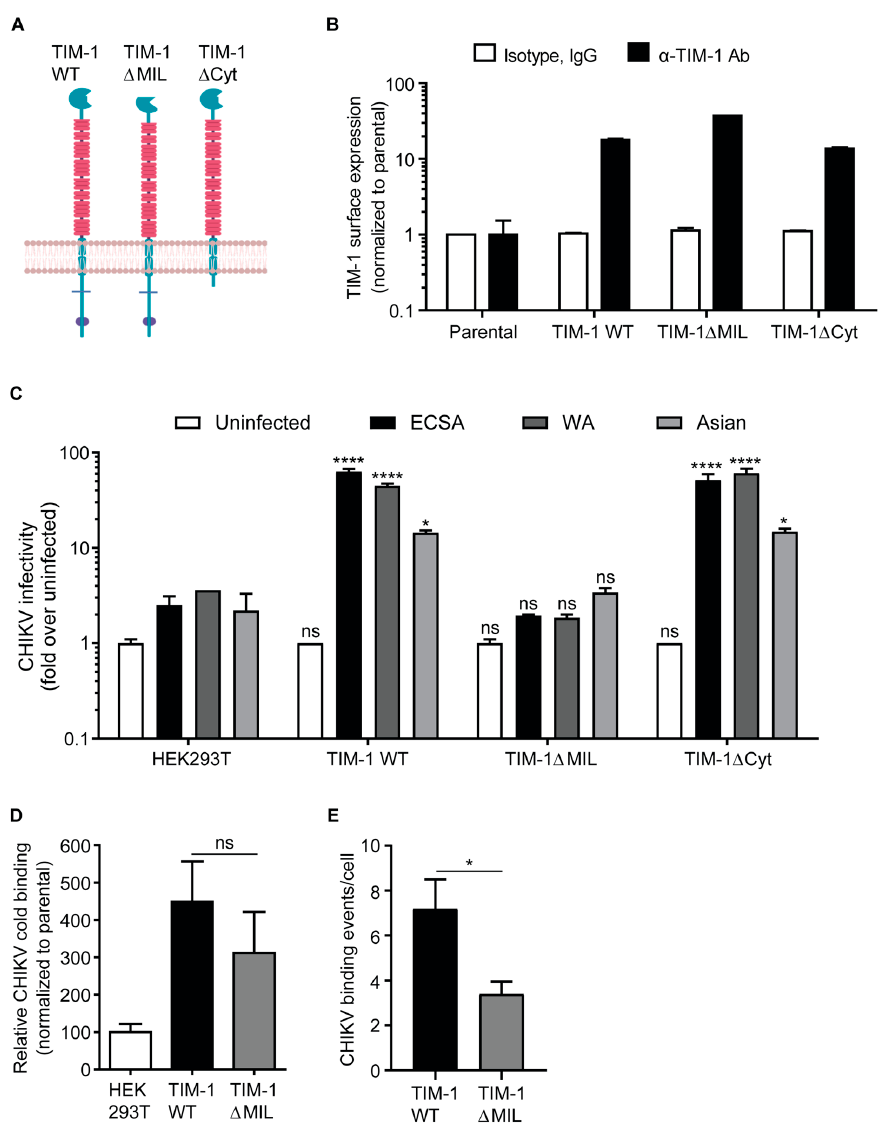
Figure 2. Phosphatidylserine-binding domain of TIM-1 is crucial for CHIKV entry and infection ( A ) Schematic representation of TIM-1 WT, TIM-1 Δ MIL with a mutation in the phosphatidylserine binding site and TIM-1 Δ Cyt that lacks part of the cytoplasmic domain (made with BioRender.com). ( B ) Expression levels of TIM-1 in parental and HEK293T cells transduced with lentiviral pseudopar- ticles to stably express TIM-1 WT, TIM-1 Δ MIL or TIM-1 Δ Cyt assessed as in Figure 1. ( C ) Parental HEK293T cells expressing TIM-1 WT, TIM-1 ∆ MIL and TIM-1 ∆ Cyt were challenged with CHIKV strains of ECSA 3 ′ GFP-CHIKV (MOI = 0.01), WA 5 ′ GFP-CHIKV (MOI = 0.01) or Asian mc-CHIKV genotypes (MOI = 0.1) and infection assessed by flow cytometry at 24 hpi. ( D ) Cold binding of flu- orescent mc-CHIKV at MOI of 50. After two hours and extensive washes, cells were fixed and ana- lyzed by flow cytometry. ( E ) Live cell imaging of CHIKV binding. Cells were inoculated with fluo- rescent Asian mc-CHIKV at MOI of 50 and monitored by confocal microscopy. Number of CHIKV binding events to the plasma membrane within 20 min were counted. The error bars represent standard errors of the mean (SEM). Statistical significance was calculated using Dunnet’s multiple comparisons test (2way ANOVA) ( C ) and Welch t -test ( E ) with ns > 0.05, * p < 0.05 and **** p < 0.0001.